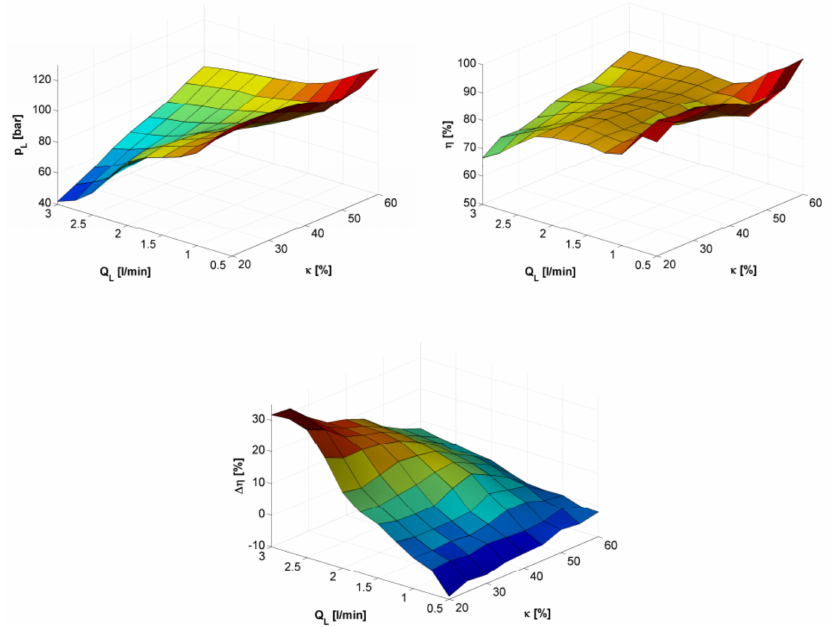
Figure 21. Measured load pressures p L , e ffi ciencies η , and e ffi ciency improvements over resistance control ∆ η of an HBC for di ff erent duty cycles κ and flow rates Q L for a switching frequency 100